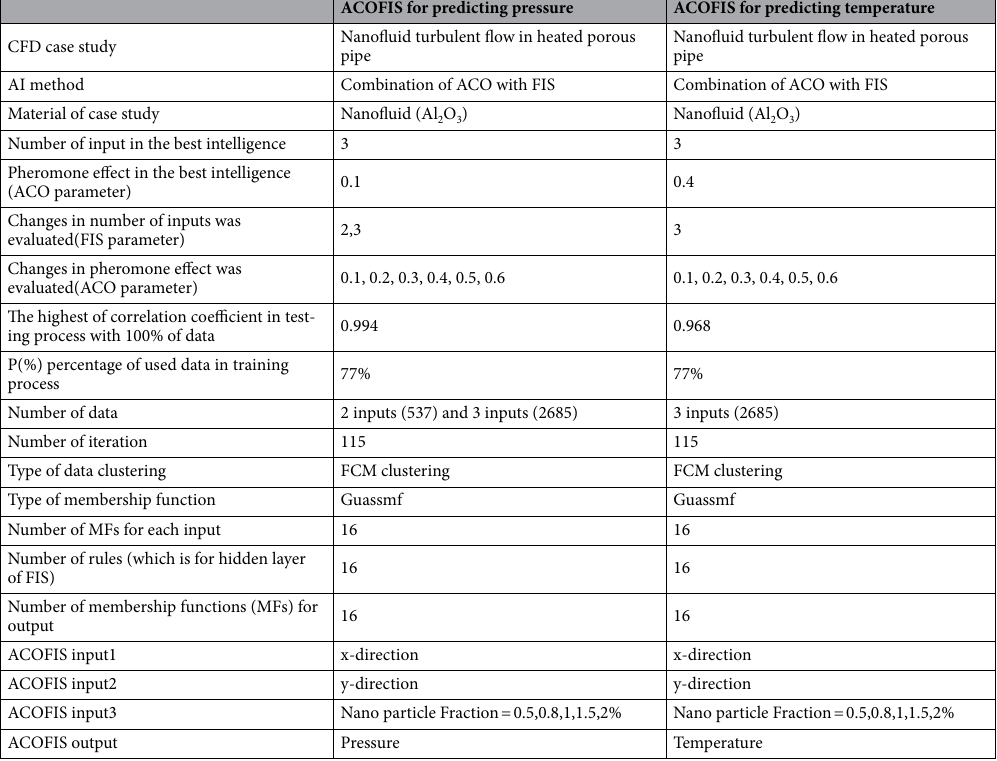
Table 3. ACOFIS setup for predicting pressure and temperature in the same setup.